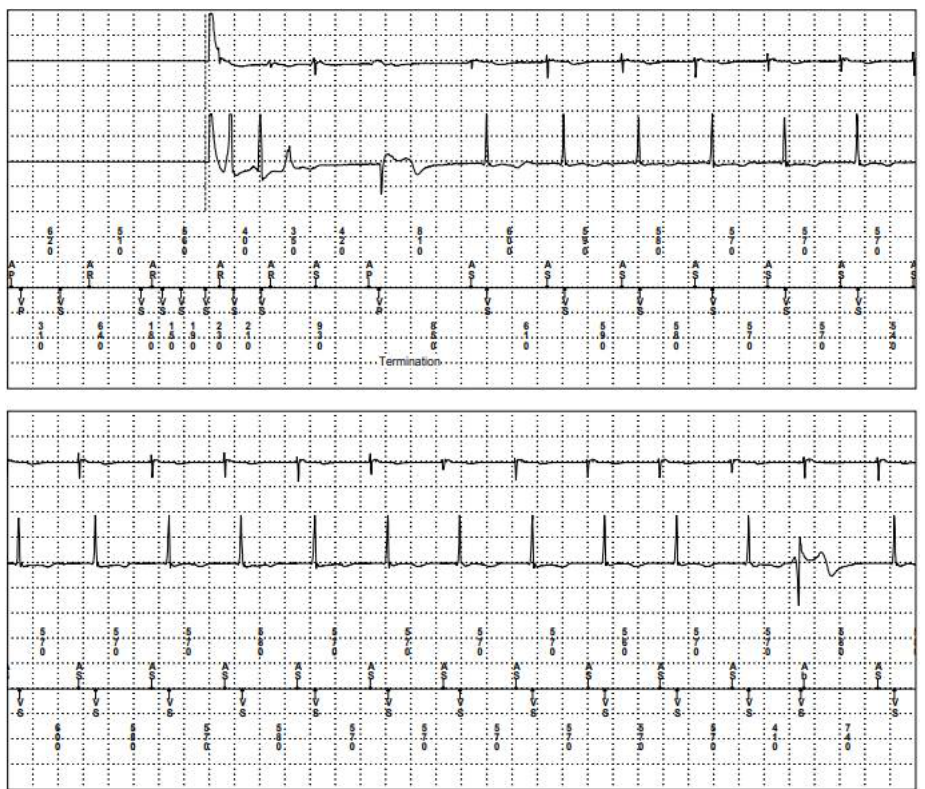
Figure 1. Ventricular tachycardia recorded on pacemaker up to 300 bpm.